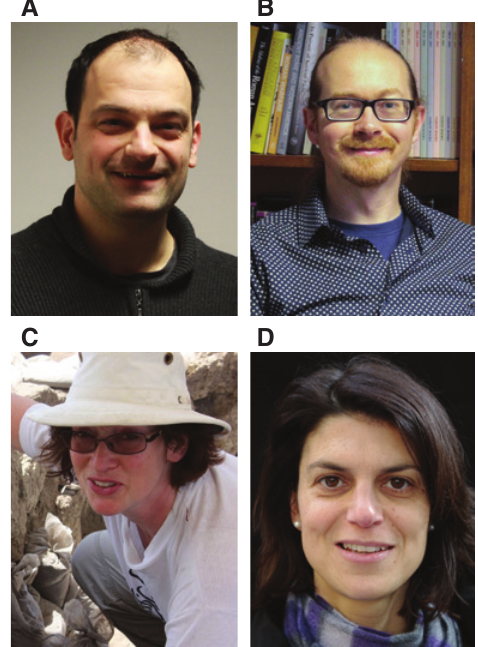
Figure 3 (A) Mark Altaweel (Source: photograph by Charlotte Frearson); (B) Andrew Gardner (Source: photograph by Lisa Daniel); (C) Louise Martin (Source: photograph by Boncucklu Project); (D) Theano Moussouri (Source: photograph by Lisa Daniel)